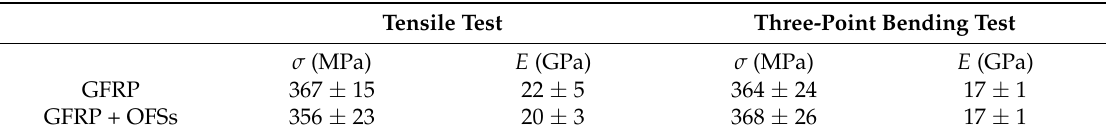
Table 1. Mechanical test results of the tensile test and three-point bending test of GFRPs with and without embedded